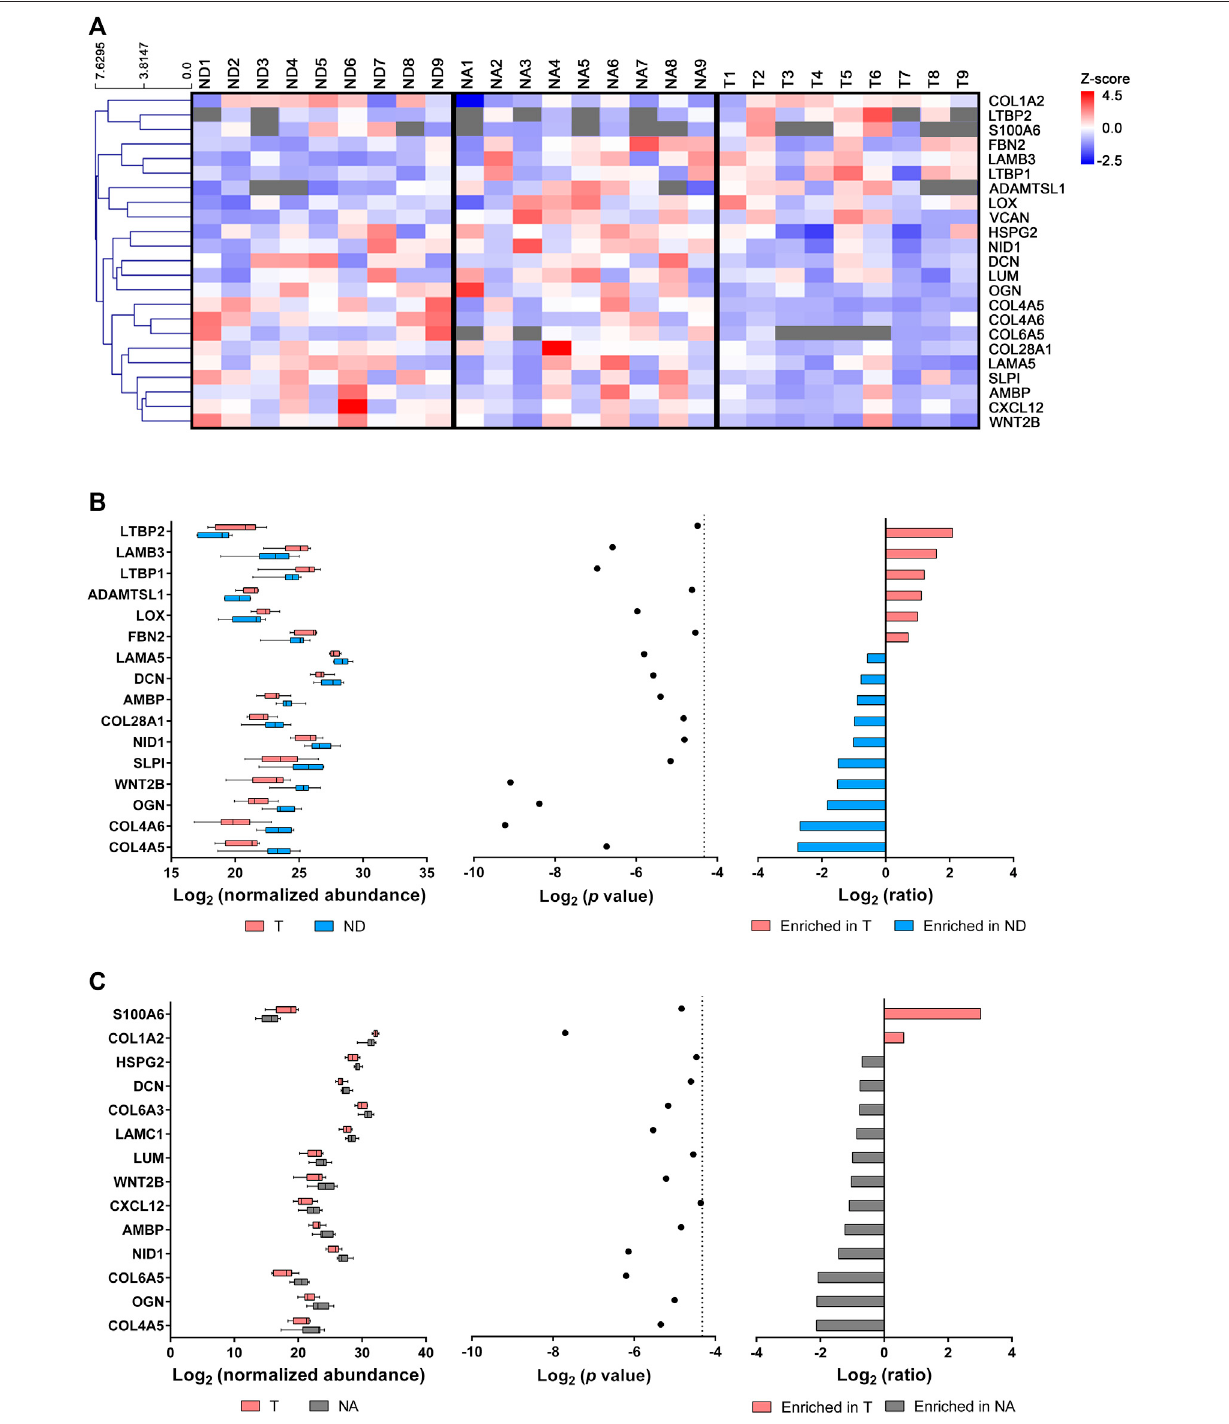
FIGURE2| Differentiallyexpressed proteinsingastricECM. (A) Heatmap representationofhierarchical clustering(averagelinkageandEuclidean metric)ofprotein expression pro fi lesindicatedaslog 2 (normalized abundance). Greyrectanglesrepresentexpression belowdetection limit. Tumor(T)ECM( n =9)yieldedsixupregulated and 10 downregulated proteins in comparison with normal distant (ND) mucosa (B) , while two were upregulated and 12 were downregulated when compared with normal adjacent (NA) mucosa (C) . Normalized abundance values were compared using a two-tailed, unpaired Student ’ s t -test corrected for multiple comparisons with the Benjamini-Hochberg method. Dotted line represents statistical signi fi cance threshold ( p < 0.05).